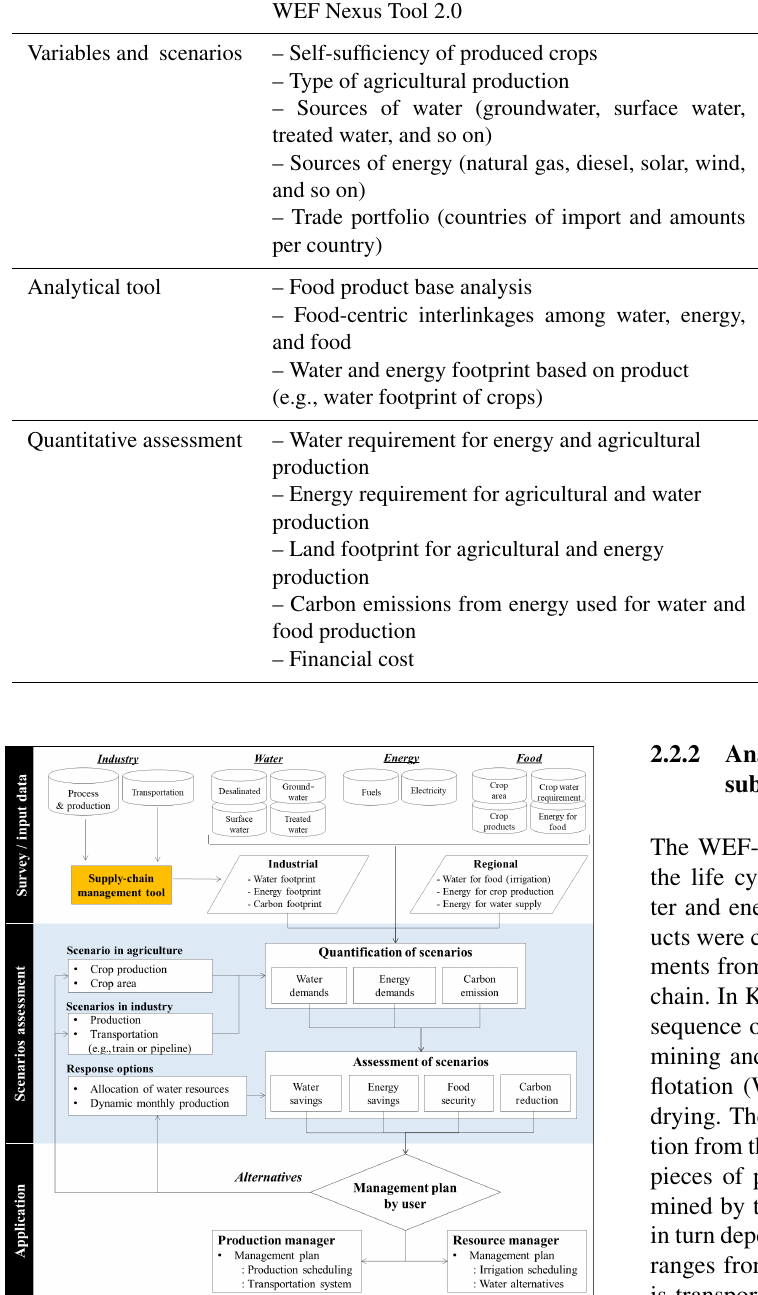
Table 1. Comparison between WEF Nexus Tool 2.0 and WEF-P Tool. WEF Nexus Tool 2.0